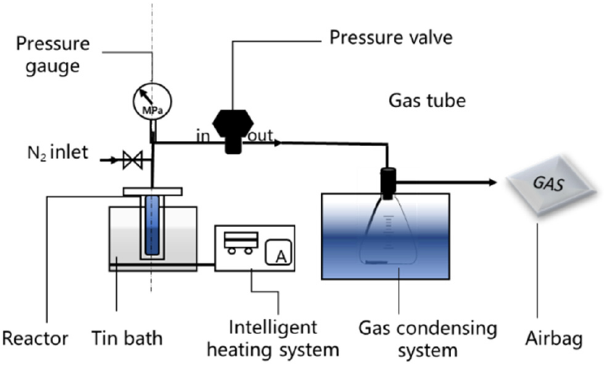
Figure 2. The thermal polymerization microreactor device.